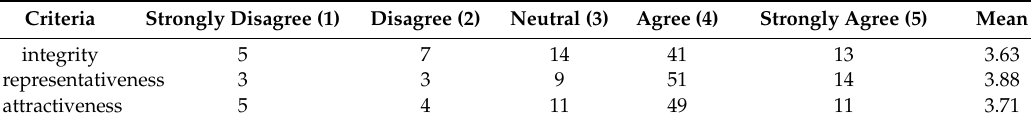
Table 4. Rating results of Q1, Q2, and Q3 in the questionnaire.